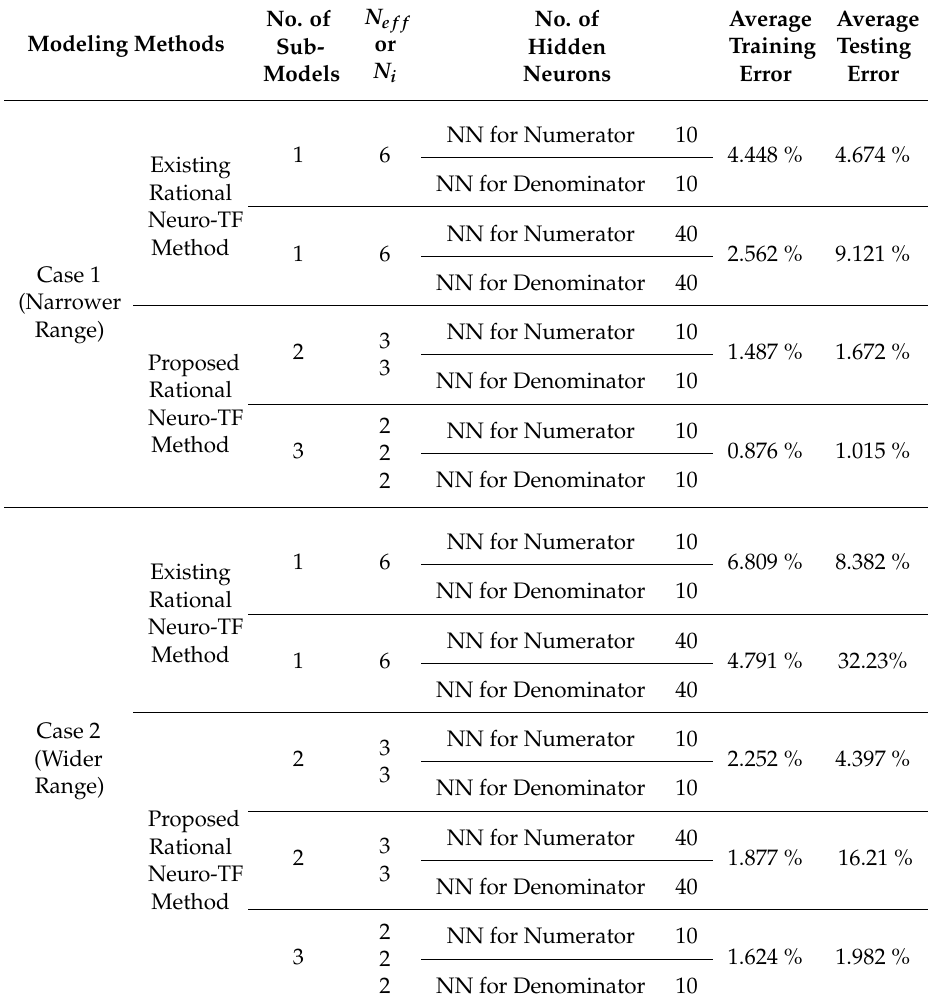
Table 5. Comparisons of different rational-based neuro-TF modeling approaches for the four-order bandpass filter